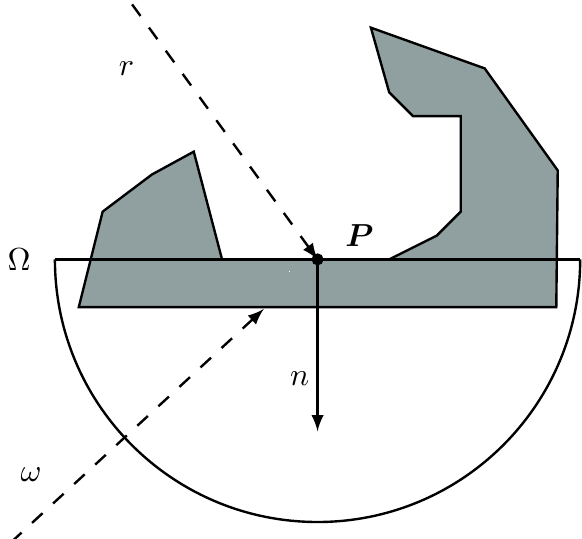
Figure 6. Example of a wrongly oriented normal that results in a false occlusion. By considering only the hemisphere Ω oriented along the normal n , the classification gives a wrong result: the ambient Ω we have an occlusion but there is at least one un-occluded ray ω occlusion term is zero. Indeed ∀ ∈ r that reaches P